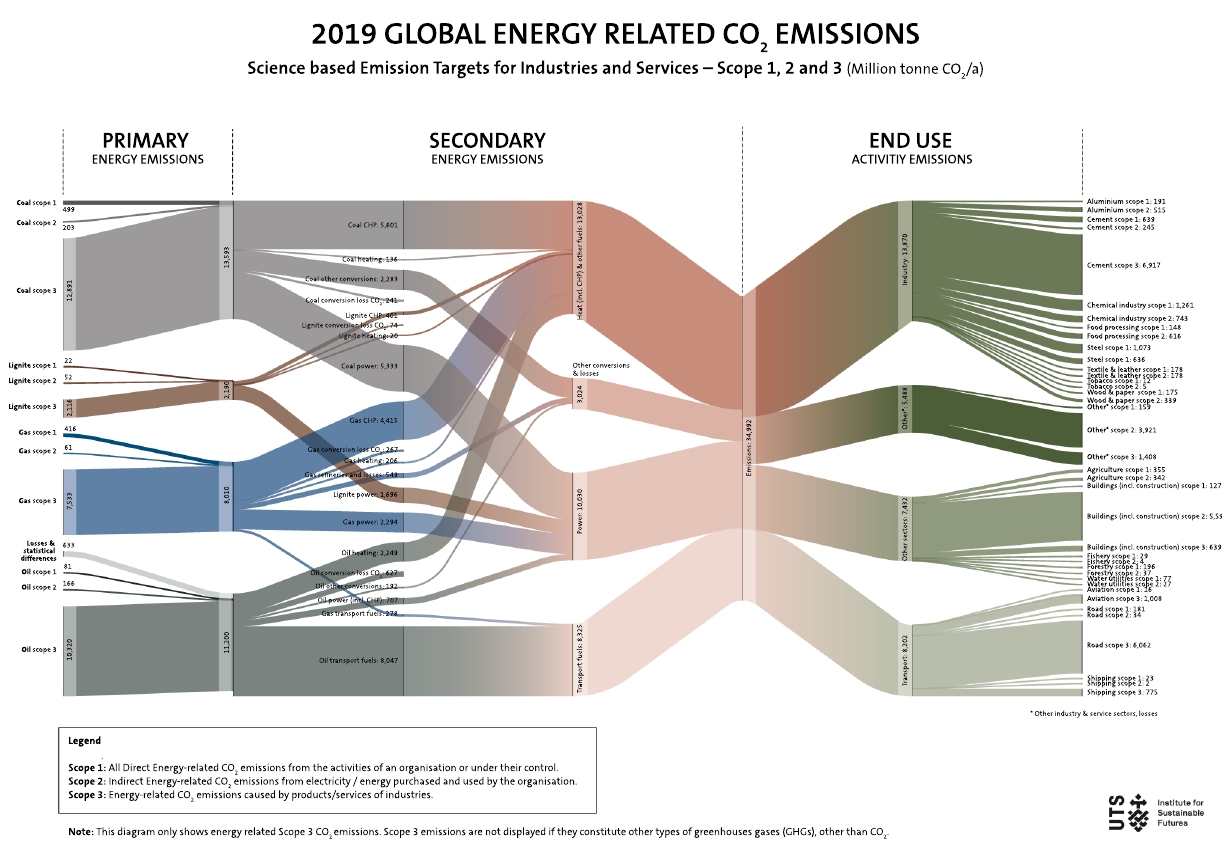
Fig. 1 Energy-related Scope 1, 2, and 3 CO emissions for the primary and secondary energy industries and for the end-use sector in 2